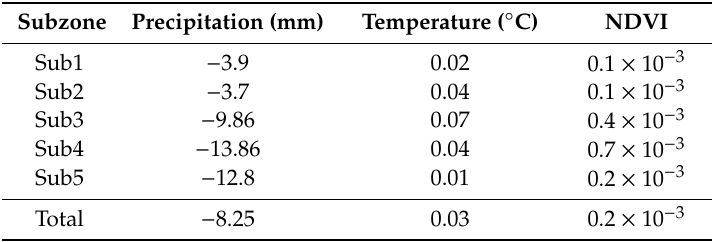
Table 3. Rainfall, temperature and the Normalized Di ff erence Vegetation Index (NDVI) perennial change